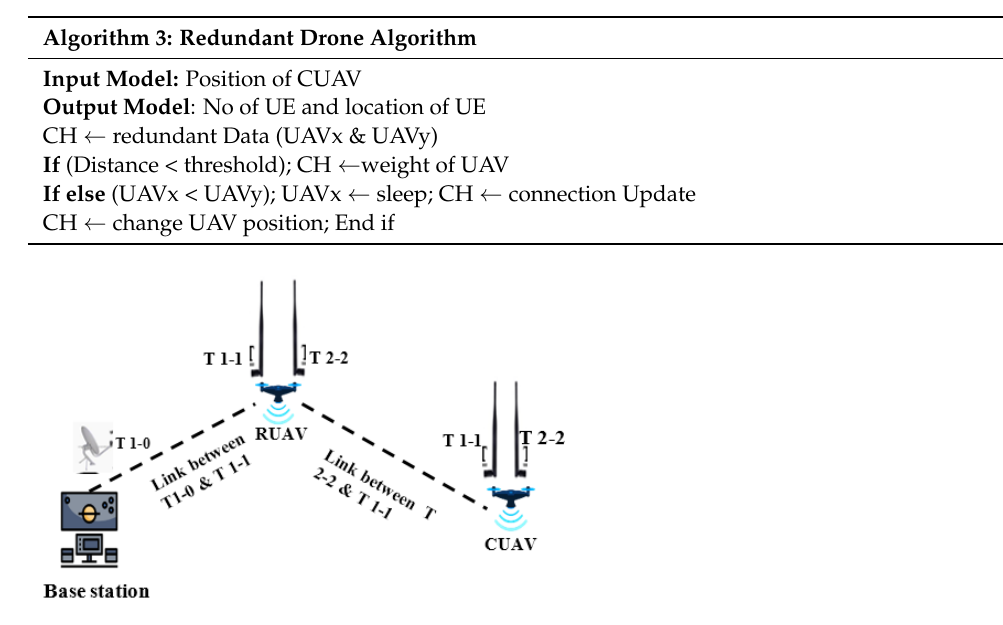
Figure 5. Architecture of communication UAVs.